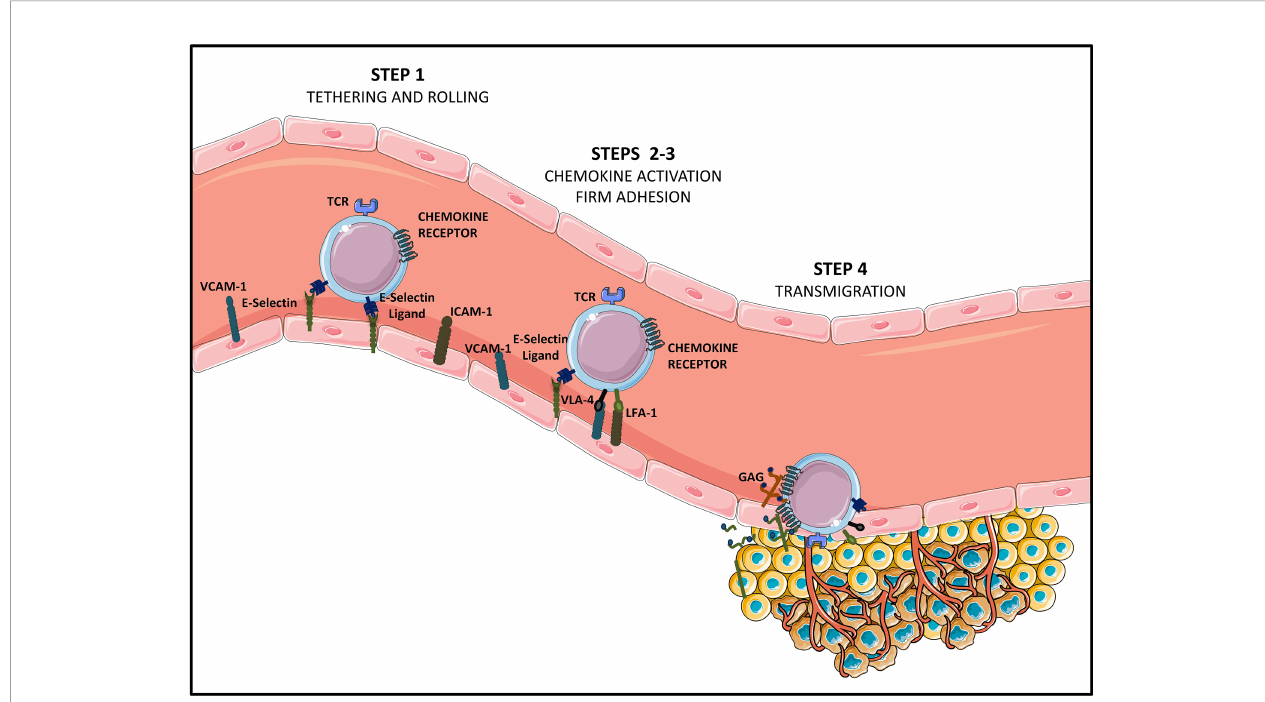
FIGURE 1 | Steps of T cell homing to tumor tissues [Adapted from Sackstein et al. (11)]. Tumor in fi ltrating CD8+ effector T lymphocytes (Teffs) presenting a speci fi c tumor antigen circulate in the blood stream. They express homing molecules allowing for their oriented migration towards the tumor (like CXCR3 and CCR5- chemokine receptors), as well as ligands allowing binding to endothelial cells (E-selectin ligands and VLA-4 and LFA-1 integrins at suboptimal levels). Circulating Teffs tether and roll on the endothelium (STEP 1) via engagement of E-Selectin ligands with endothelial E-Selectin, which slows down Teffs, and allows fi rm adhesion to the endothelium (STEP 2). In this second step of Teffs entry into tumoral tissues, chemokines produced by cancer cells or by stromal cells from the TME (CXCL9, CXCL10, CCL5 … ) bind chemokine receptors. This binding of chemokine receptors to their ligands elicits activation of VLA-4 and LFA-1, allowing for VLA-4/VCAM-1 and LFA-1/ICAM-1 fi rm adhesion (STEP 3). Firmly adherent Teffs undergo transendothelial migration (STEP 4), to in fi ltrate the TME and establish cell-to-cell contact with tumor cells, via TCR-based recognition of cancer antigens presented on HLA